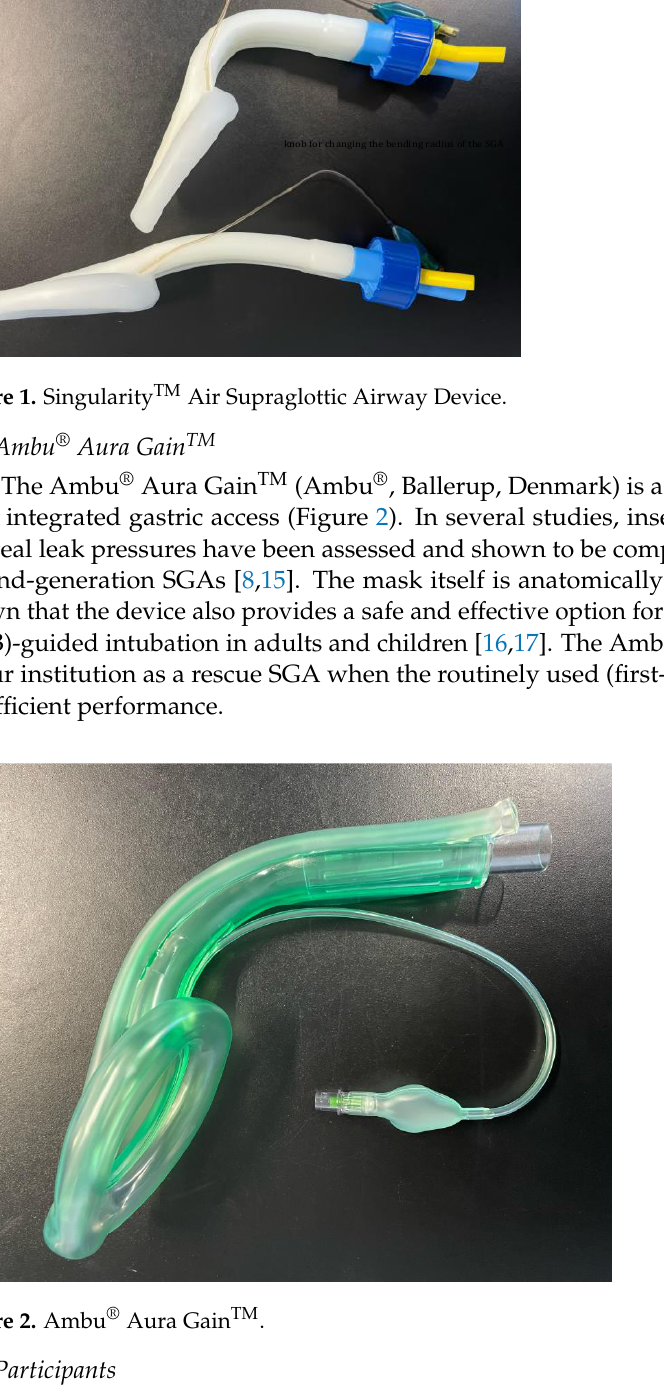
Figure 1: Singularity TM Air Supraglottic Airway Device